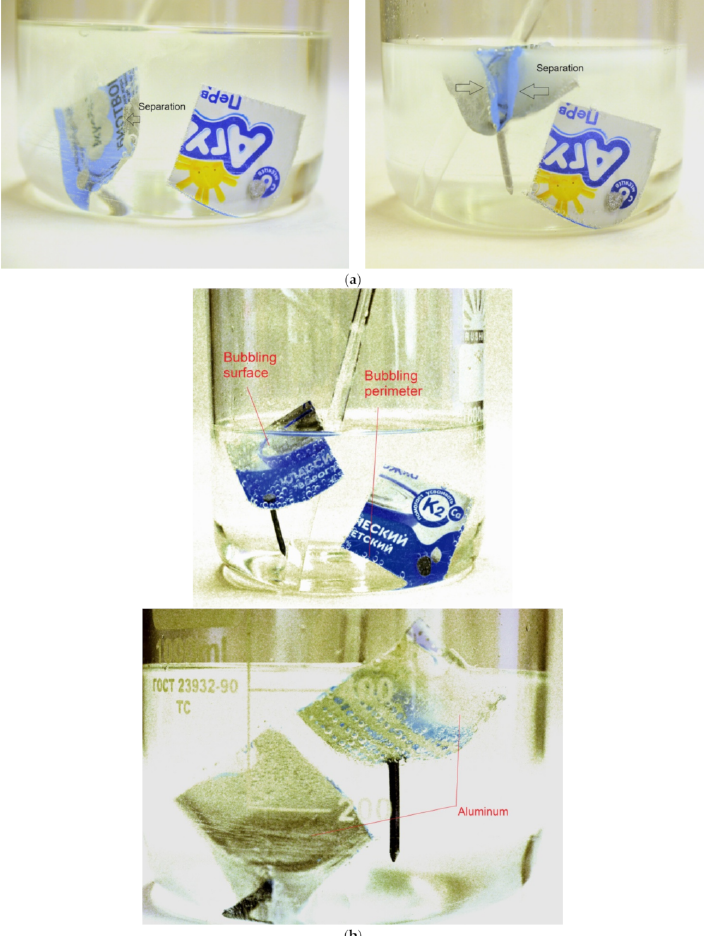
Figure 9. Illustration of the differences between different lid pieces: ( a ) difference between lids from different manufacturers; ( b ) difference between lids with and without perforations, front and rear